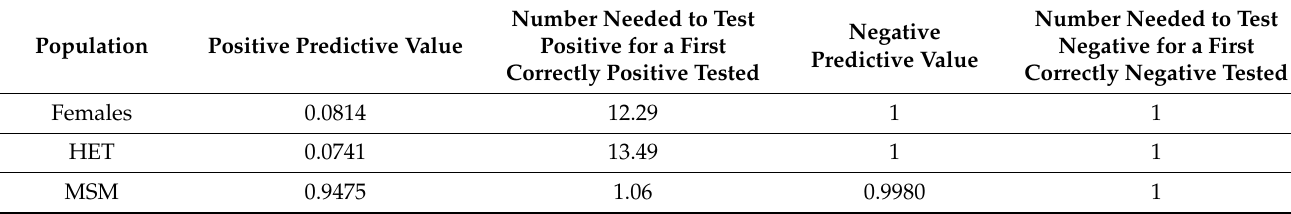
Table 5. Positive and negative predictive values for the Ag/Ab RDT component of the case definition after day 10.